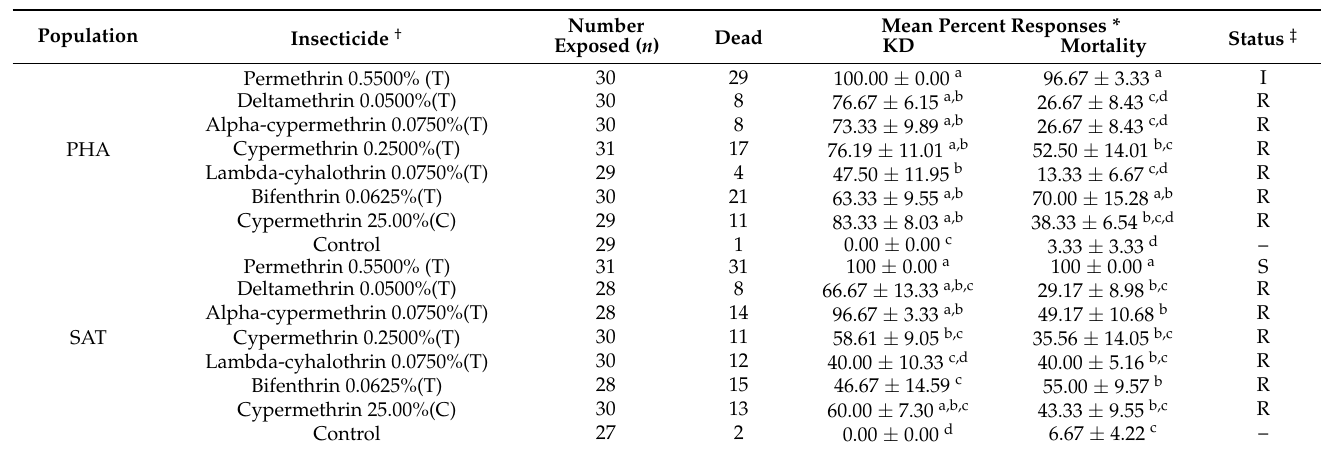
Table 3. Wild Stomoxys indicus (males and females) adults, from Phattalung (PHA) and Satun (SAT) populations, percent knockdown (KD) at 60 min and 24 h mortality (percentage ± SE) after exposure to an insecticide at recommended concentration for six technical-grade and one commercial- grade